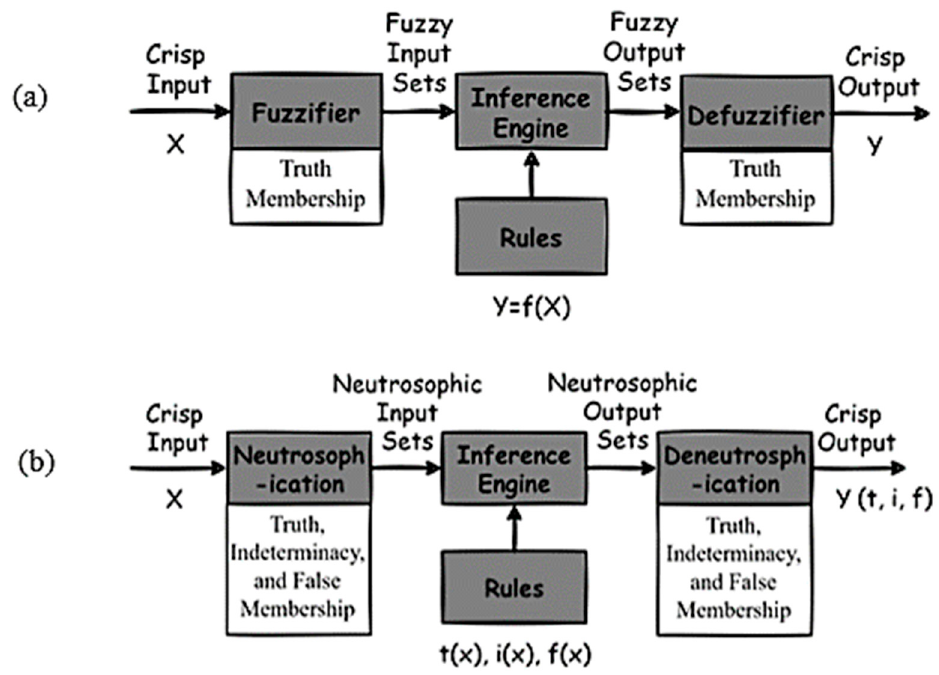
Figure 1. Inference systems: ( a ) fuzzy logic ( b ) neutrosophic logic.